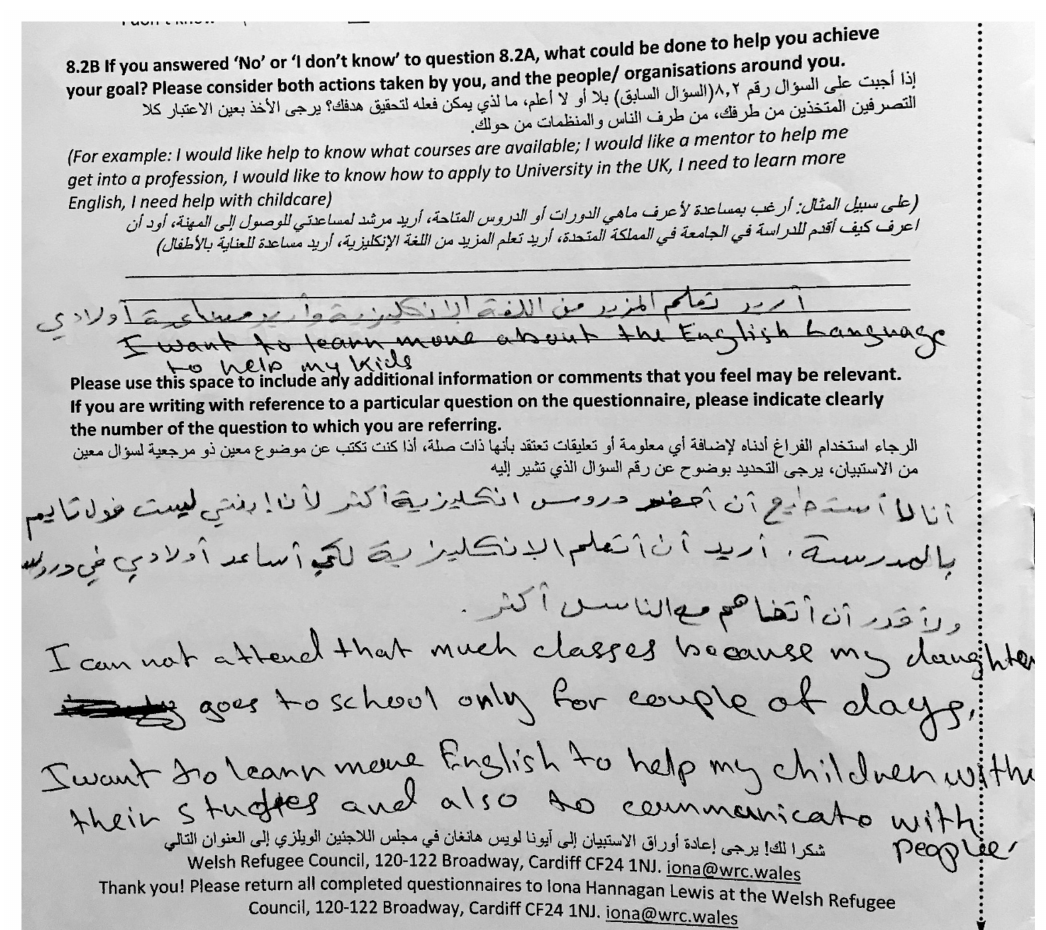
Figure 3. Photograph of page from a questionnaire. The Arabic translates as: “I want to learn more about the English language to help my kids / I cannot attend that much classes because my daughter goes to school only for a couple of days. I want to learn more English to help my children with their studies and also to communicate with